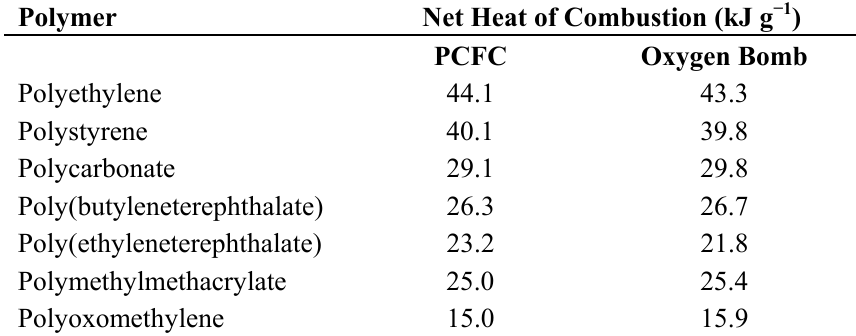
Table 4. Net heats of combustion of selected polymers by PCFC and oxygen bomb calorimetry